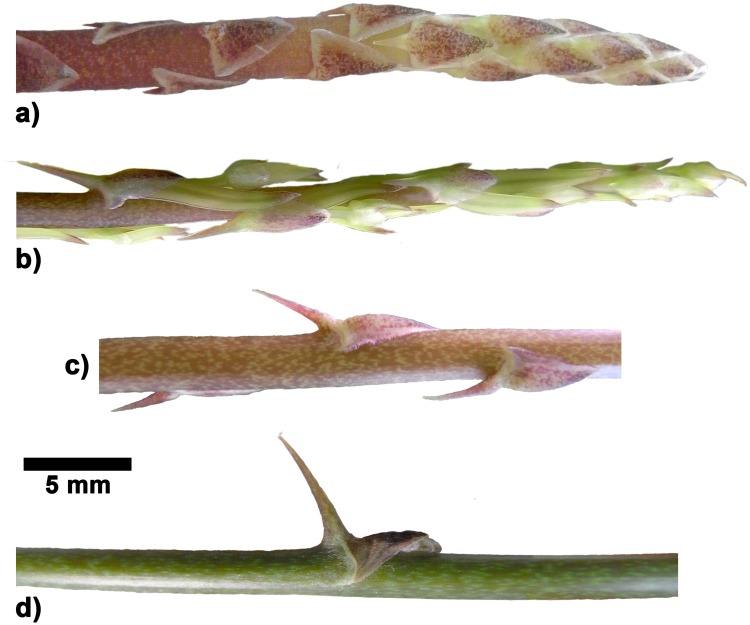
Morphology of stems and spines in Asparagus falcatus.a) shoot tip with spines lying flat against the axis, b) same shoot tip 5 days later with emerging axillary buds, c) transition zone with spines elevated at different angles, d) zone near the apex with fully developed spines erected at higher angles (≤ 80°).